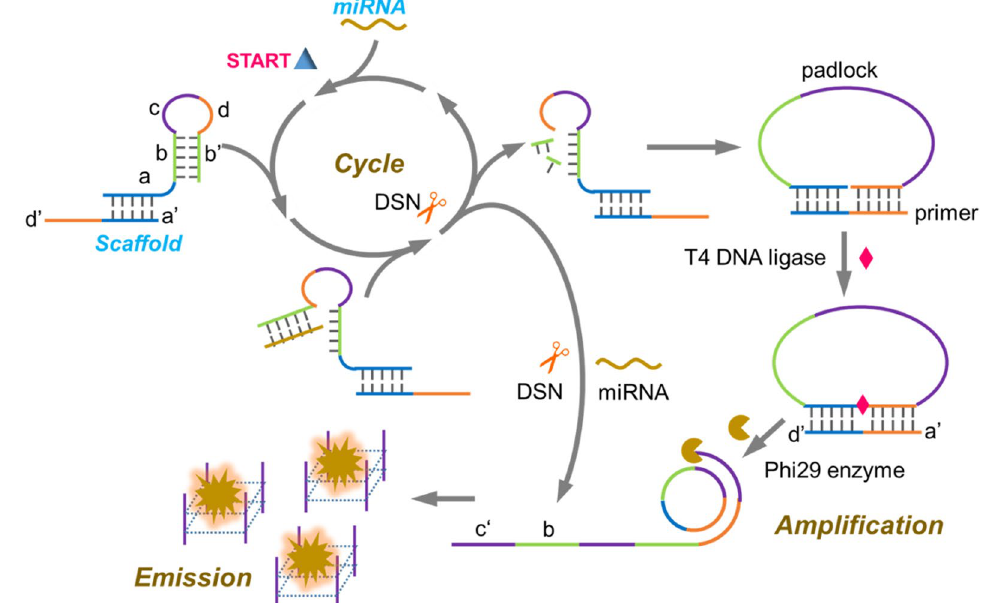
Fig. 1 The working mechanism of the established